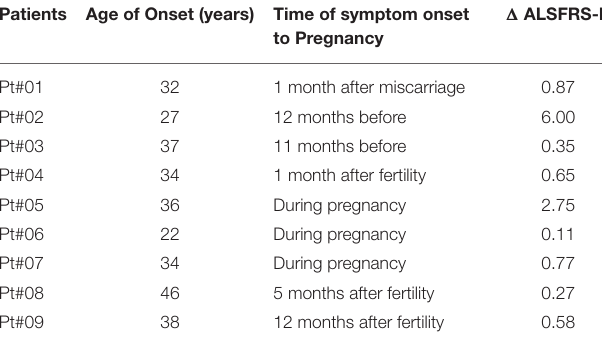
TABLE 3 | Linear regression analysis assessing the association between clinical features and progression rate in the female cohort.